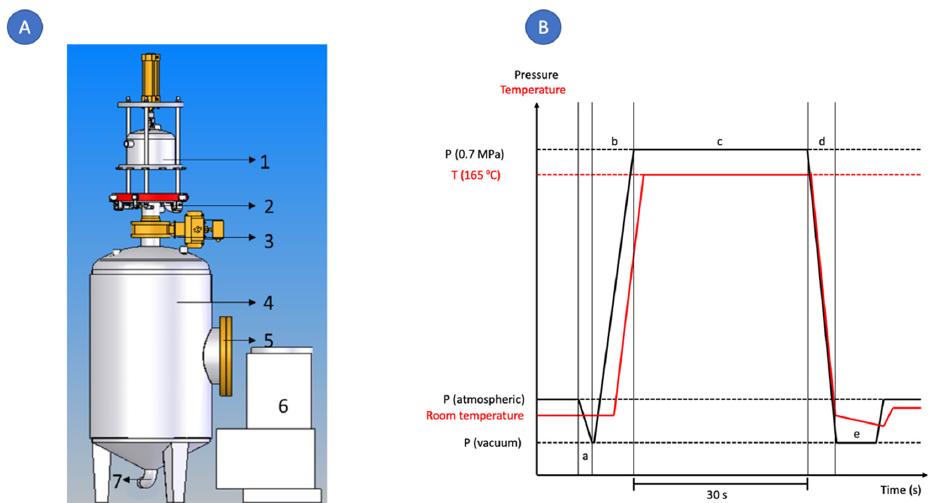
Figure 5. ( A ) Schematic representation of a DIC laboratory equipment (1) Double-walled bell, (2) Crown, (3) Decompression valve, (4) Vacuum tank, (5) Manhole, (6) Vacuum pump, (7) Condensates